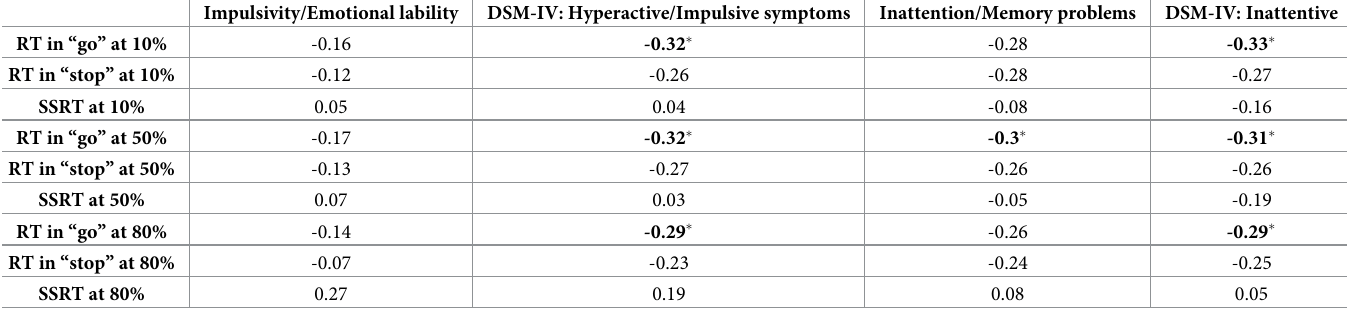
Table 14. Values of Spearman’s ρ for correlations between simple RT/ accuracy-based measures and impulsivity/inattention measures in the mouse movement con- dition calculated at different coherency levels. Impulsivity/Emotional